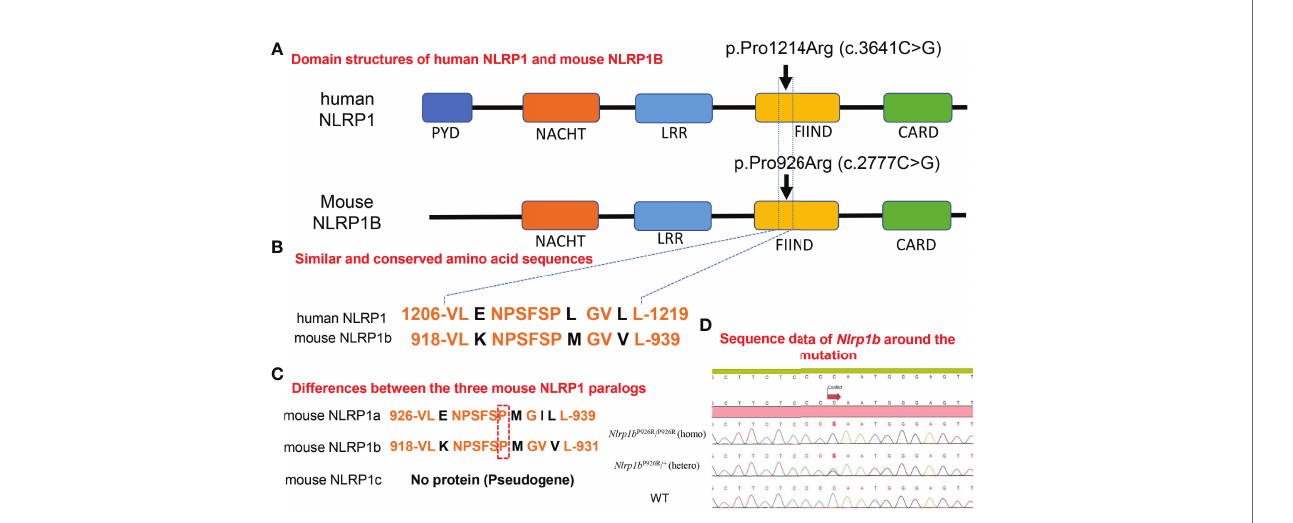
FIGURE 1 | Homology in domain structures and amino acid sequences between human and mouse NLRP1 and the present knock-in mutation. (A) Domain structures of human NLRP1 and mouse NLRP1B. The previously reported pathogenic mutation in NLRP1 in humans, and the missense mutation we inserted into the BALB/c mice in this study. (B) Similar and conserved amino acid sequences between human NLRP1 and mouse NLRP1B. (C) Differences between the three mouse NLRP1 paralogs. (D) Sequence data of Nlrp1b around the mutation in Nlrp1b KI mice (mutant- Nlrp1b P926R / P926R : homo, mutant- Nlrp1b P926R / + : hetero) and WT